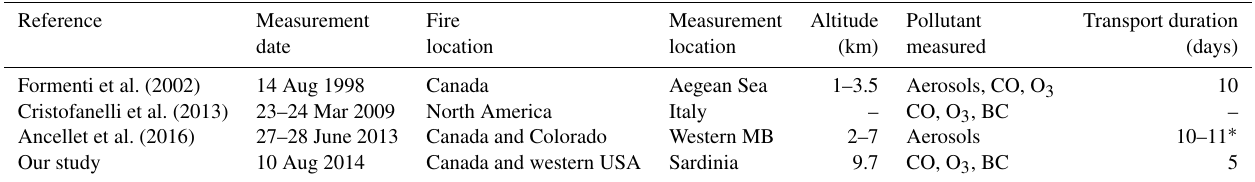
Figure 4. (a) 6 August 2014 at 08:51UTC; (b) 24 July 2014 at 18:37UTC; (c) 2 August 2014 at 06:58UTC. (Left) CALIOP overpass (red line) and area of CO vmr averaging (blue box) from AIRS. (Middle) Vertical distribution of aerosol subtypes (smoke in black) associated with the red line of the CALIOP orbit. (Right) CO vertical distribution from AIRS with data averaged according to the location of the blue box. Table 2. List of the biomass burning layers coming from the North American continent that impacted the MB reported in the literature. The altitude refers to the measurement